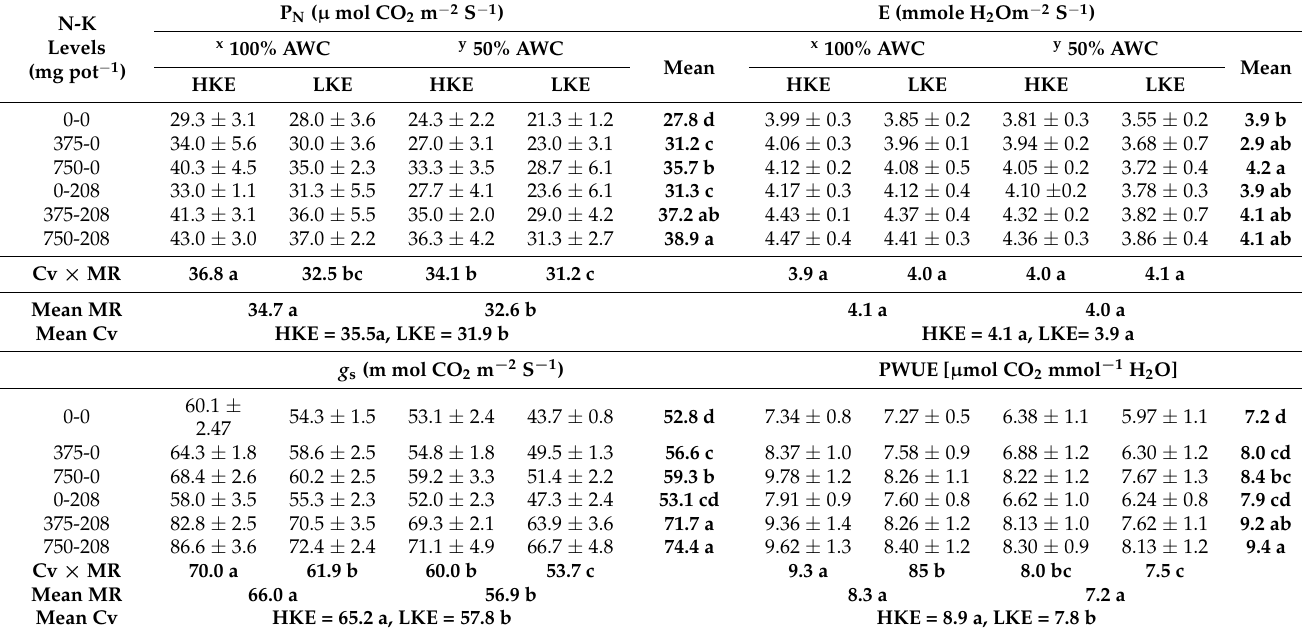
Table 1. Effect of applied N:K levels on gas exchange characteristics and PWUE in cotton cultivars under varied irrigation